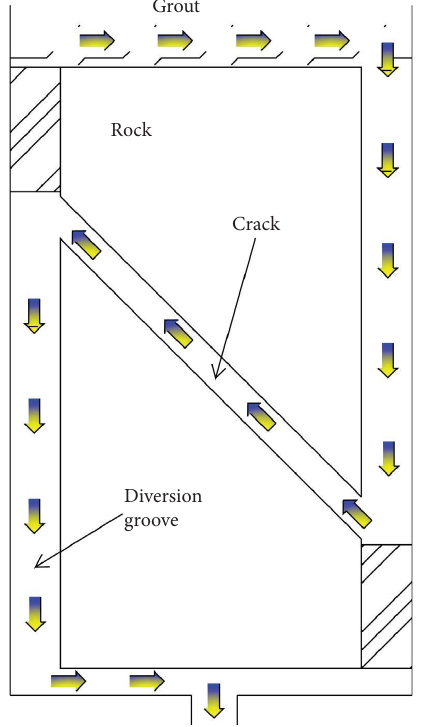
Figure 4: Schematic diagram of the grout flling process.